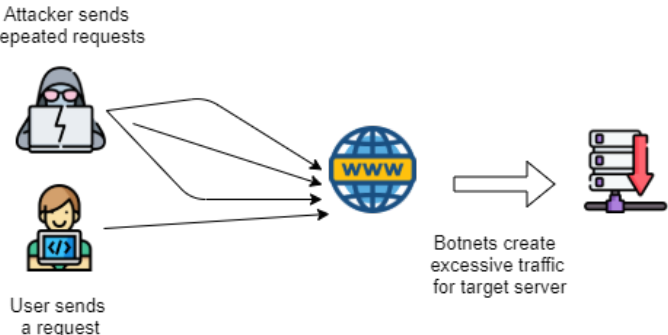
Figure 8. Graphical representation of a denial of service attack [87].